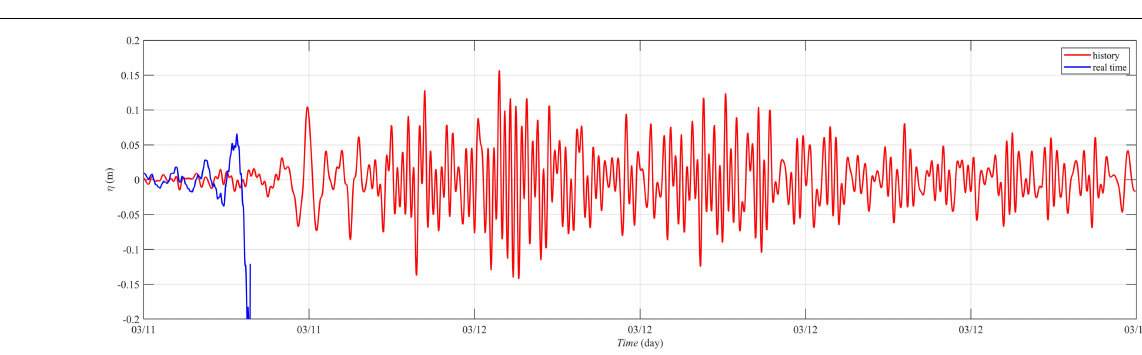
FIGURE 10 | Band pass filtering method is used to analyze the comparison results of observation data and historical data in real time.